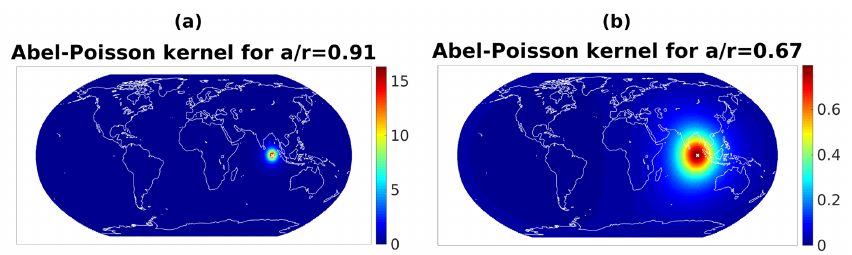
Figure 1. The kernel K(r · ,aη 1 ) for a